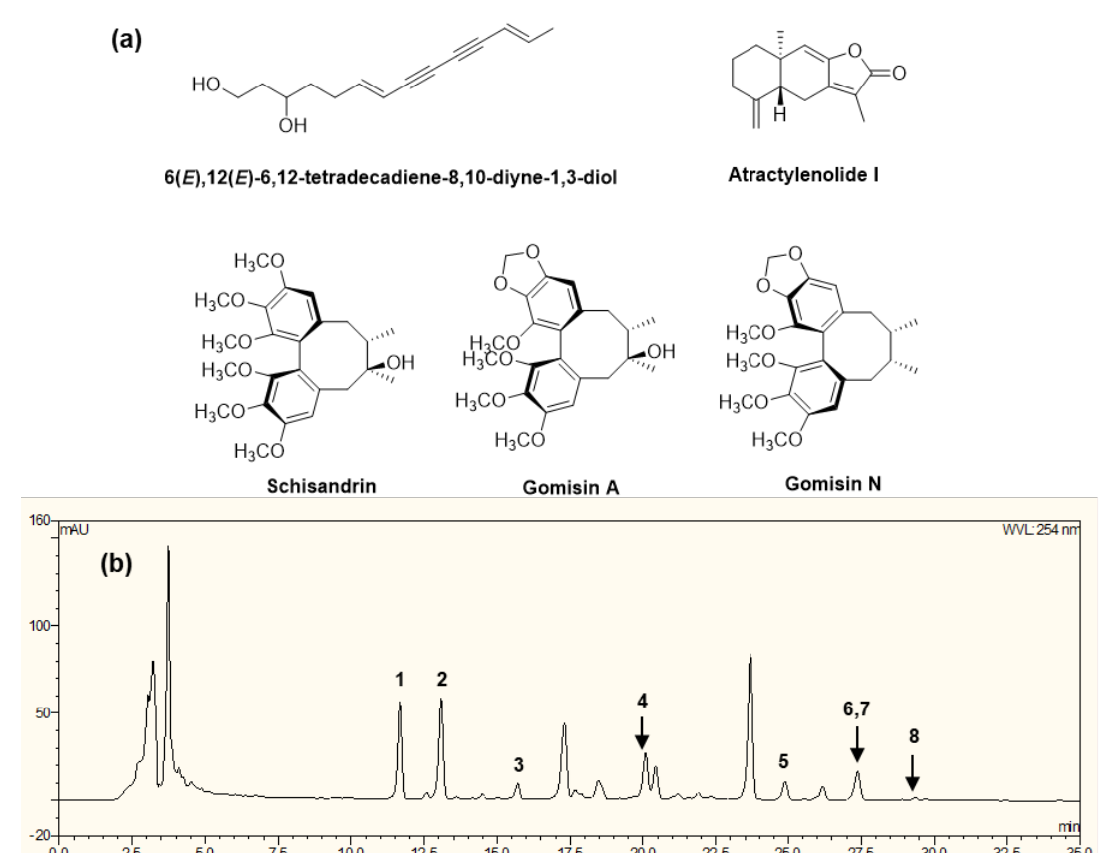
Figure 1. Isolated compounds ( a ) and HPLC-UV analysis of CKD-497 ( b ) 1. 6( E ),12( E )-tetradecadiene- 8,10-diyne-1,3-diol, 2. schisandrin, 3. gomisin A, 4. atractylenolide I, 5. schisandrin A, 6. gomisin N, 7. γ-schisandrin, 8. schisandrin C.